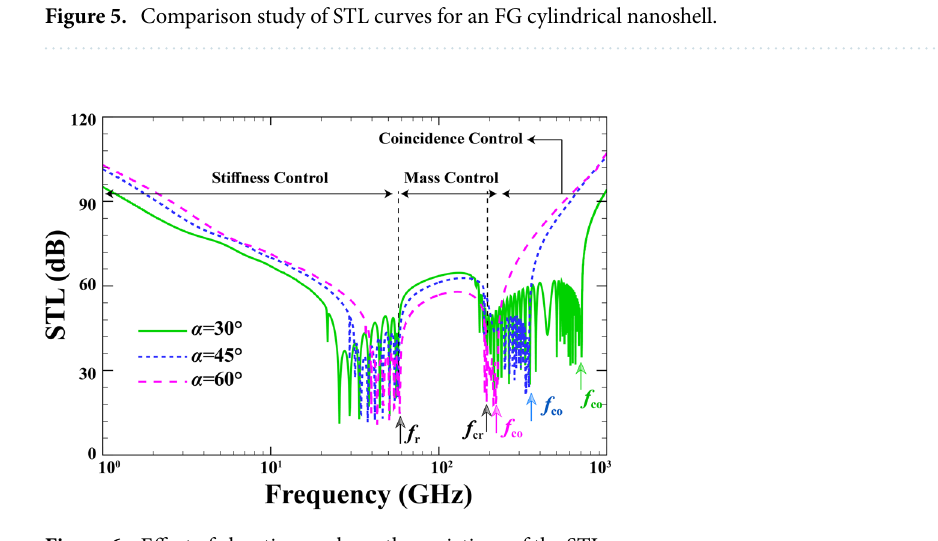
Figure 6. Effect of elevation angle on the variations of the